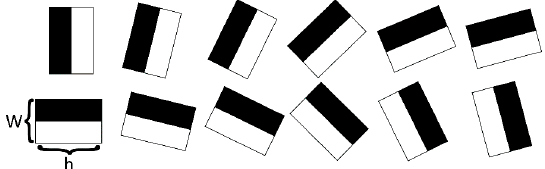
Figure 5. The two-rectangle Haar-like feature, rotated at twelve angles (revised from [62]).